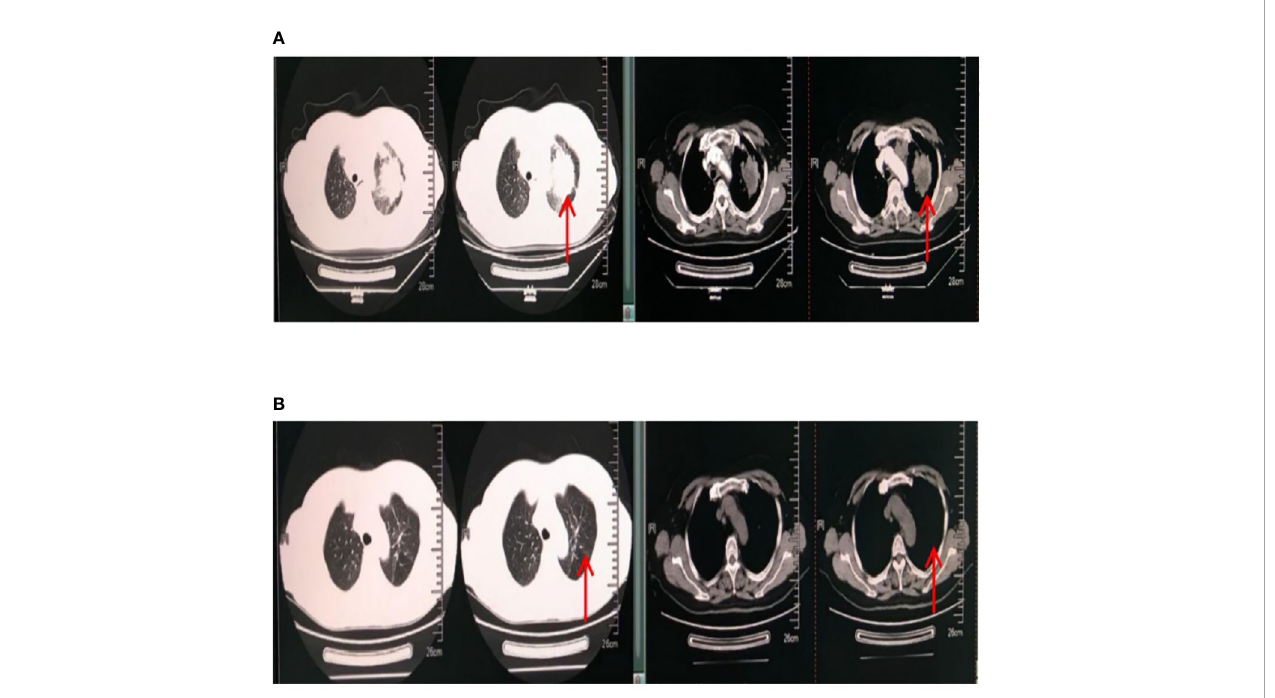
FIGURE 2 Chest CT results. The red arrow points to the lung tumor. (A) Chest CT results on 13 December 2017 (before treatment). The maximum cross-sectional area of the space-occupying lesion in the upper lobe of the left lung was 7.3 cm × 5.5 cm. Multiple metastatic lymph nodes were found in the mediastinum and neck. There was pleural effusion in the left chest. (B) Chest CT results on 27 May 2019 (after treatment). The maximum cross-sectional area of the space-occupying lesion was 9 mm × 4 mm. Multiple small lymph nodes were found in the mediastinum and